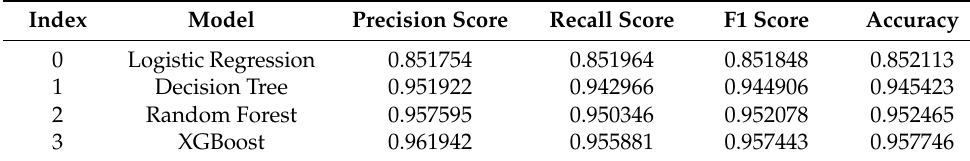
Table 3. Evaluation metrics on down-sampled data.